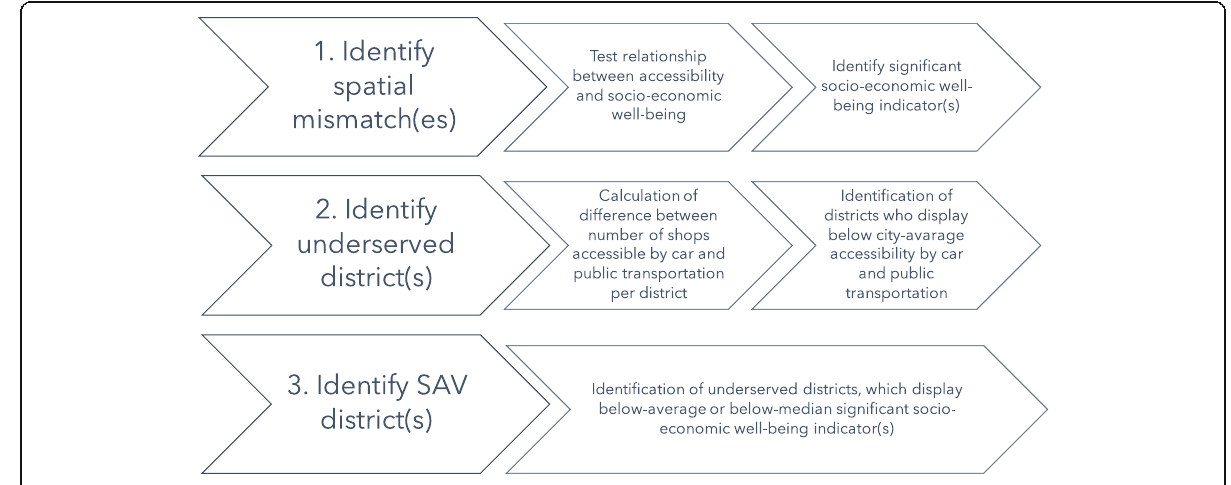
Fig. 1 Three-step process to identify SAV